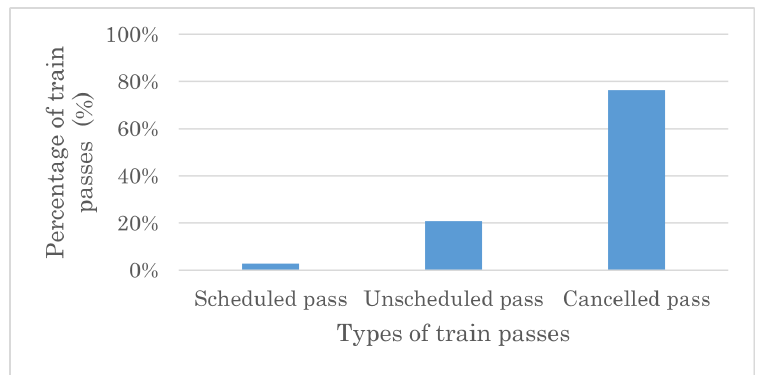
Figure 3. Distribution of different types of train